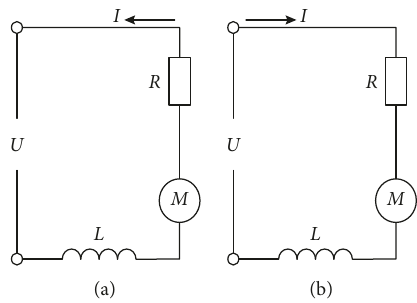
Figure 4: Schematic of the control circuit model. (a) Generator. (b) Motor.